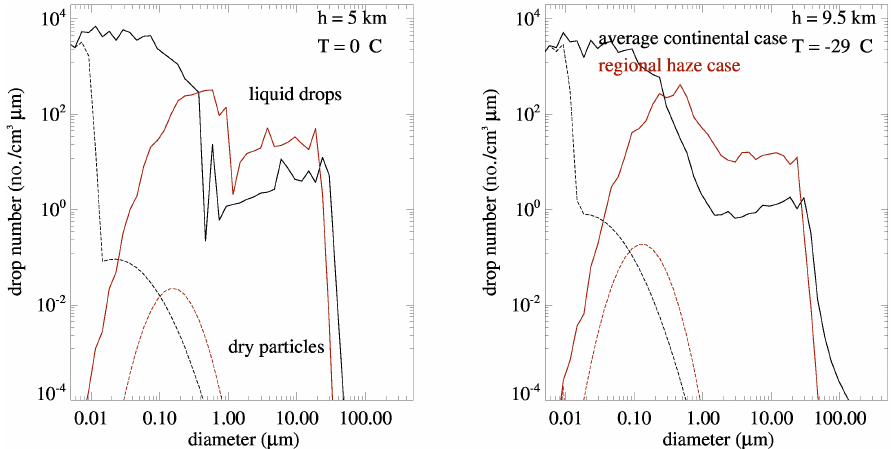
Figure 9. Results from model runs without freezing. Development of liquid drop (solid lines) and interstitial particle numbers (dashed lines) with altitude for two initial aerosol particle number size distributions: average continental (black lines), regional haze (red lines), with (cid:49)T = 2K. Number concentrations per cm 3 and µm as a function of particle diameter. Table 5. Ice water fractions from sensitivity studies with immersion freezing. Liquid clouds: IWF < 0.1, mixed-phase clouds: 0.1 ≤ IWF ≤ 0.9, and ice clouds: IWF > 0.9. Cases referring to mixed-phase clouds and ice clouds are written in